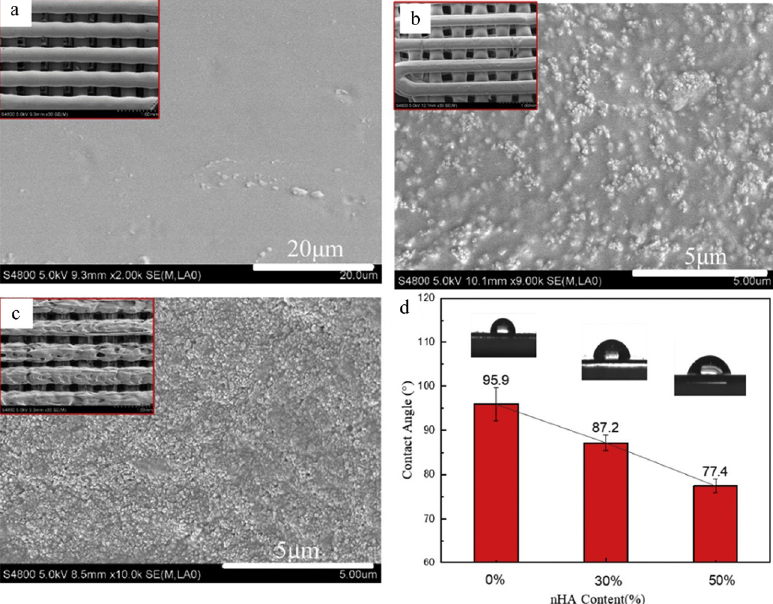
Figure 8: The morphology of composite sca ff olds with di ff erent nHA contents, ( a ) PLLA sca ff olds, ( b ) 30% nHA composite sca ff olds, ( c ) 50% nHA composite sca ff olds, ( d ) the water contact angle of the di ff erent composite.